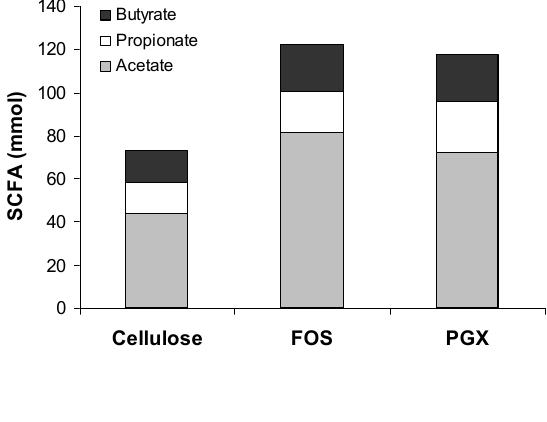
Figure 3. Contribution of acetate, propionate and butyrate to total SCFA production in TIM-2 at 72 h on the fructooligosaccharide (FOS), PolyGlycopleX (PGX) or cellulose substrate. Data are mean values ( n = 2 for FOS and cellulose and n = 3 for